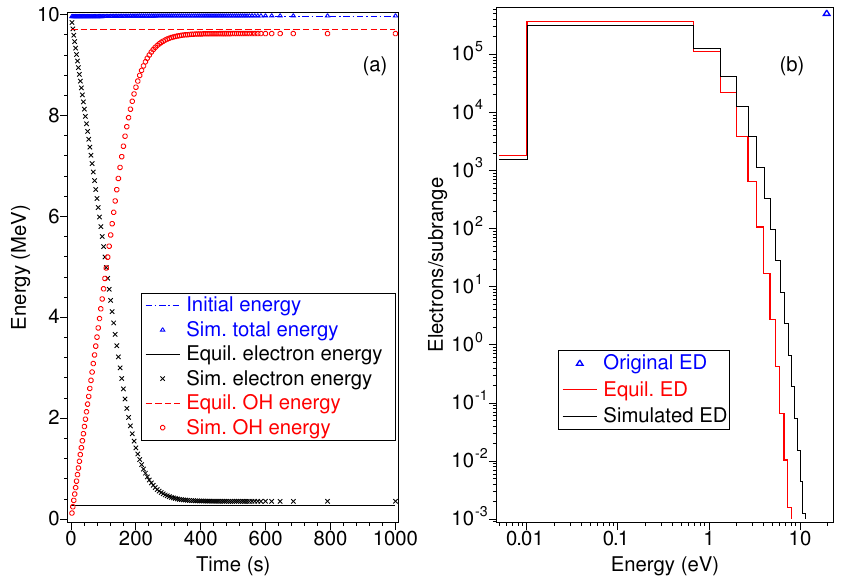
Figure 4. Simulated (symbols) and equilibrium (lines) values of ( a ) gas, electron and total energies for N = 30 with a linear distribution of subrange boundaries The simulated values are plotted as a function of time at every thousandth time step. The electron distributions ( b ) are shown for the original ( (cid:52) ), predicted equilibrium (thick line) and simulated at 1000 s (thin line).